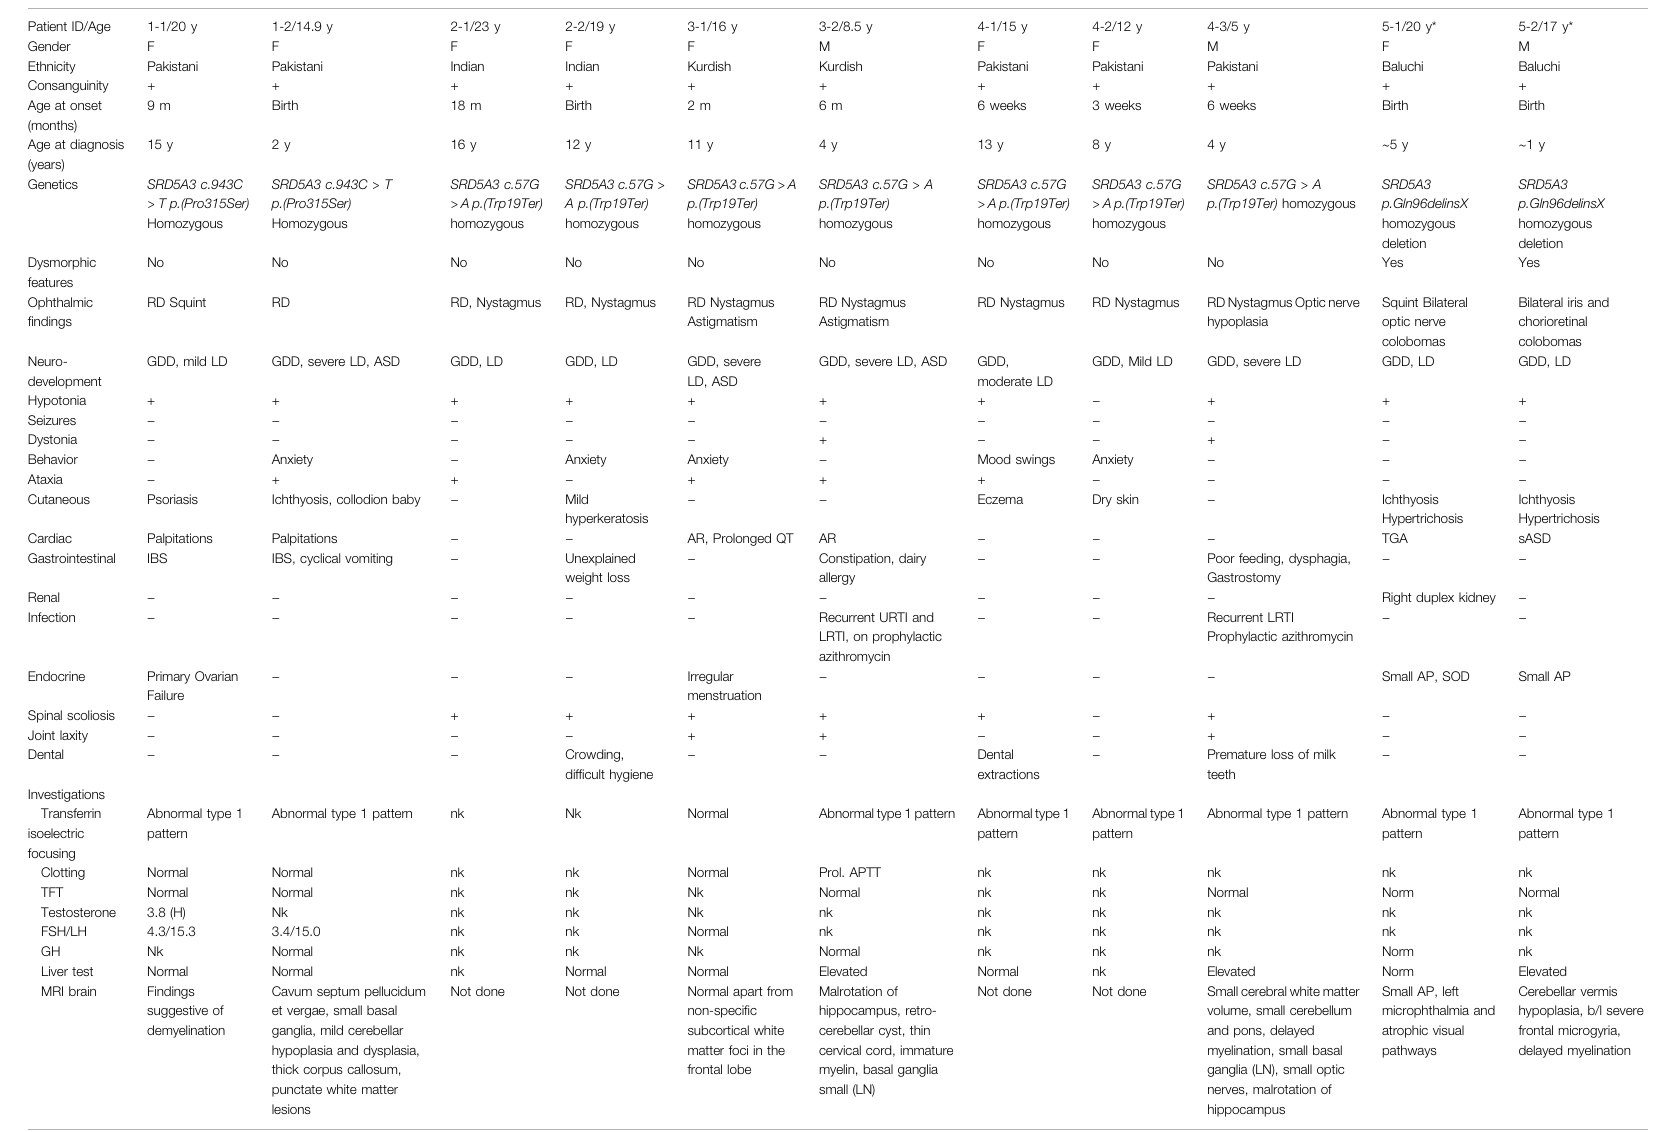
TABLE 1 | Clinical characteristics of patients with SRD5A3-CDG in our cohort of 11 patients. Phenotypic presentation of 11 patients with SRD5A3-CDG Patient ID/Age